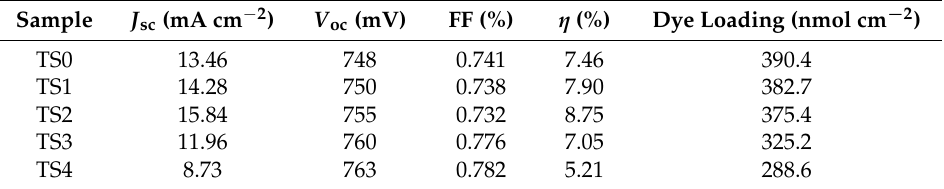
NWAs (TS1, TS2, TS3,